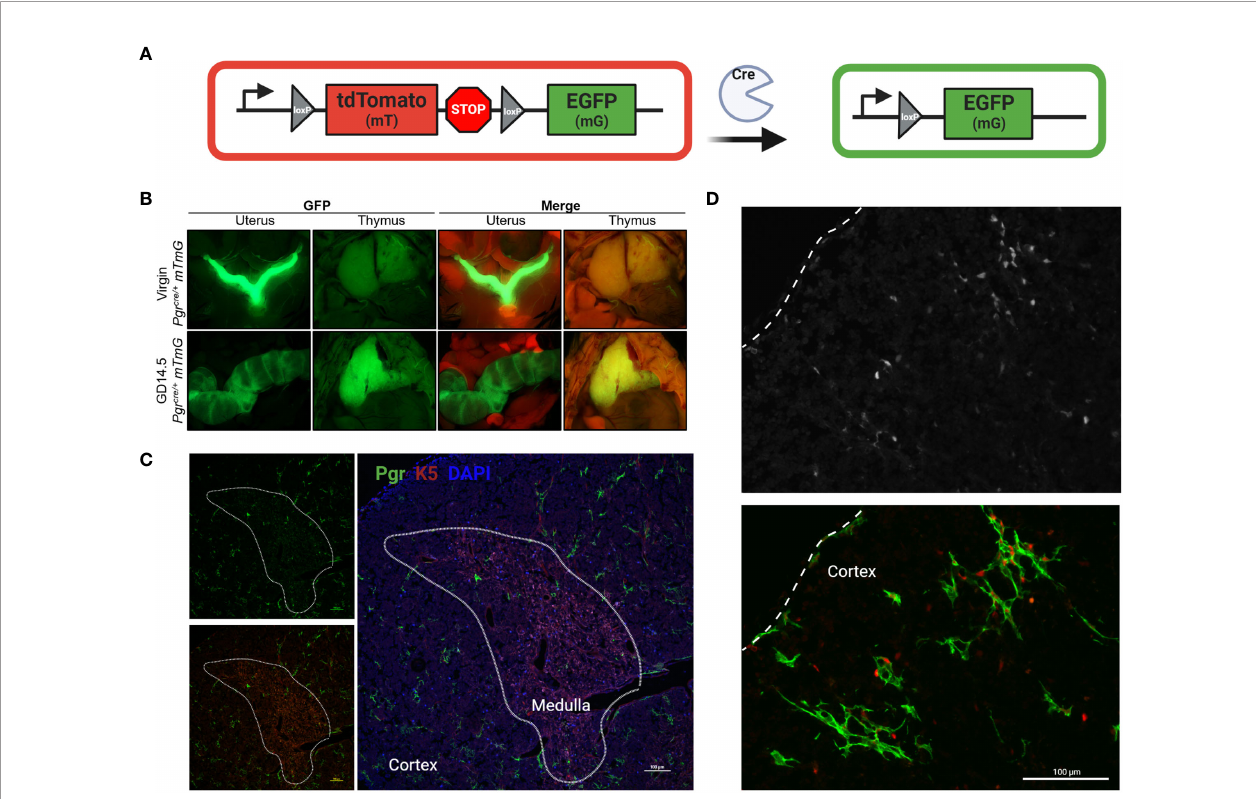
FIGURE 3 | Pgr reporter system identi fi es PGR + cells in the cortex of the thymus in pregnancy. (A) Explanation of Cre/Rosa26mTmG reporter system. In the absence of Cre recombinase activity, all cells remain mT+ (red). Upon expression of Pgr gene, Cre recombinase generation mediates the excision of the mT cassette. Post recombination, the cell membrane of all PGR+ cells will become GFP+. (B) Macroscopic visualization of GFP expression in the thymus at GD14.5 compared to virgin control. (C) Partially stitched Pgr cre/+ ;Rosa26 mTmG/mTmG thymus at GD14.5 to demonstrate GFP+ expression in the cortex of the thymus. K5 denotes medulla. DAPI = nuclei, PGR = GFP+ cells. The dotted lines outline the medulla. Magni fi cation: 200x, Scale bar = 100 m m. (D) Pgr cre/+ ;Rosa26 mTmG/mTmG thymus at GD14.5 stained with anti-PGR primary antibody and counter stained with anti-rabbit secondary antibody (Alexa Fluor 405), pseudo-colored red to provide contrast to GFP+ cells. Dotted line indicates the capsule of the thymus. Magni fi cation: 200x, Scale bar = 100 m